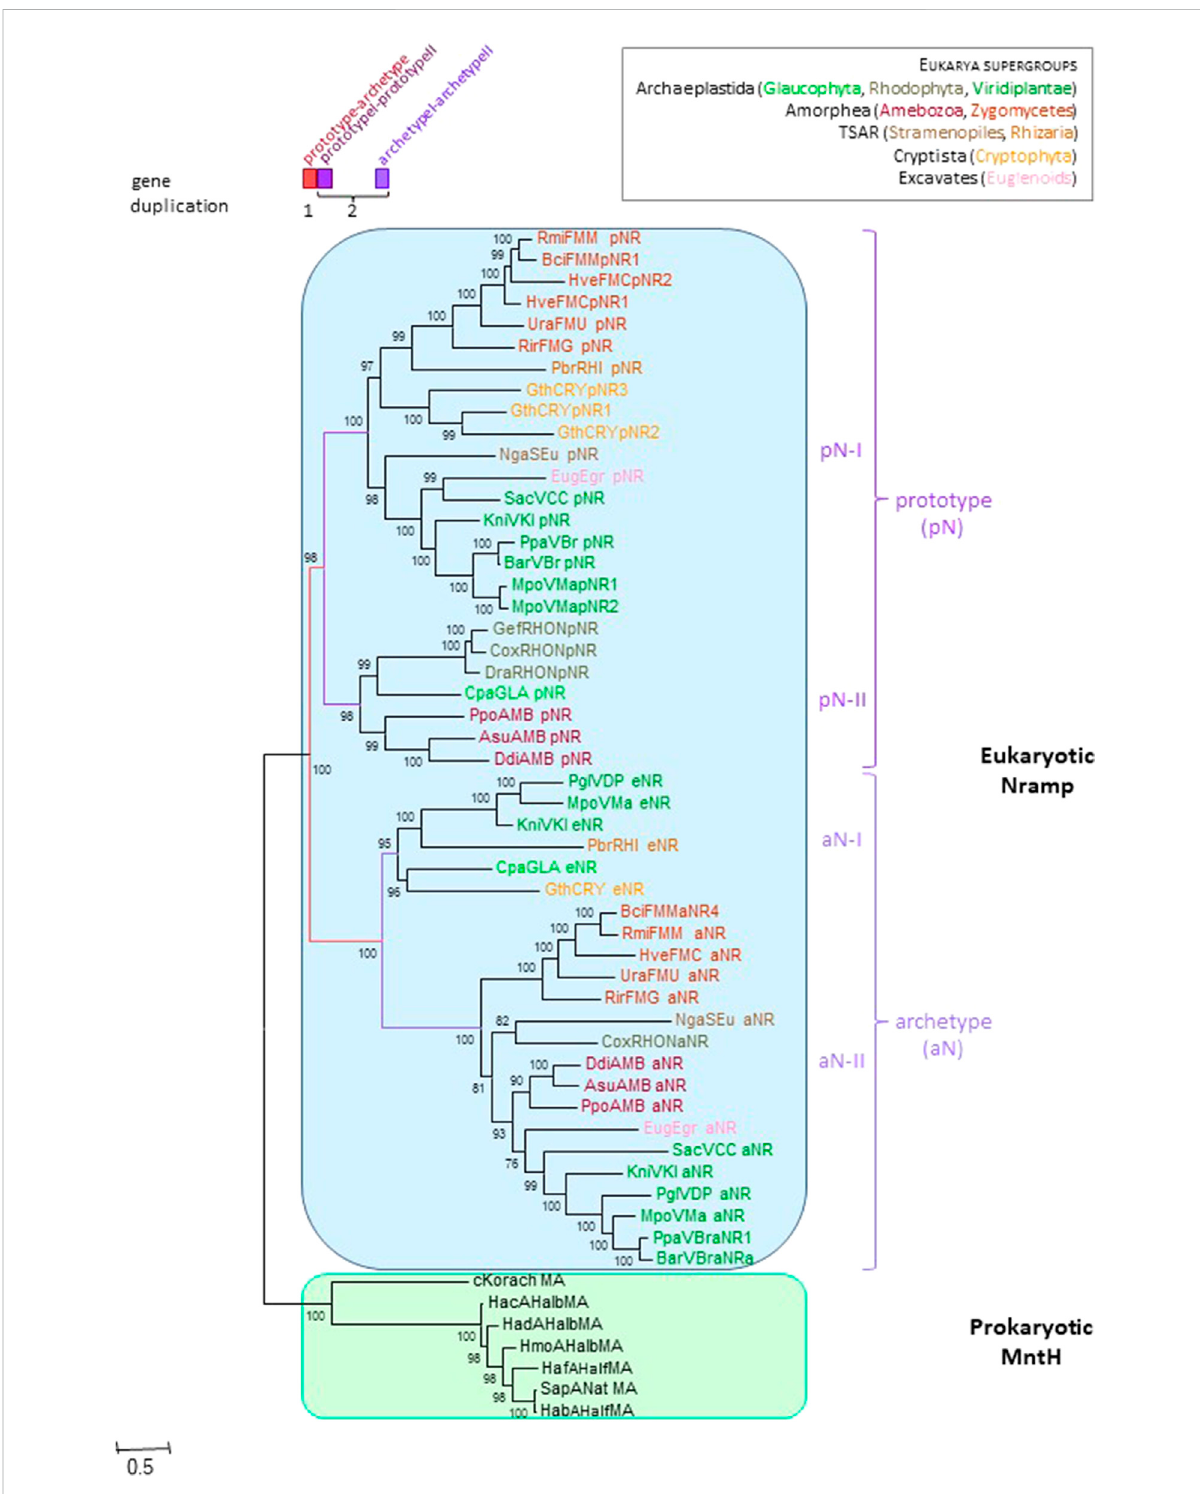
FIGURE 1 Nramp diversi fi cationearlyineukaryoteevolution.TheIQ-treepresentedused278parsimonyinformative(PI)sites,thesubstitutionmodelEX3, ML estimateofa.a. state frequency,freerate modelofvariation amongsiteswith 13categories(Leetal., 2008;Tri fi nopoulosetal., 2016).Sequences distribution( eukaryoticsupergroups ): Amorphea ,Fungi(FMM,MUC,FMC,FMG:pN-I&aN-II)andAmoeba(AMB:pN-II&aN-II); TSAR ,Stramenopiles (SEu: pN-I & aN-II) and Rhizaria (RHI: pN-I & aN-I); Archaeplastida , Green algae (VCC: pN-I & aN-II), Land plants (VKl, VMa: pN-I, aN-I & aN-II; VBr: pN-I & aN-II; VDP: aN-I & aN-II), Red algae (RHO: pN-II & aN-II) and Glaucophyta (GLA: pN-II & aN-I); Cryptophyta (CRY: pN-I & aN-I); Euglenozoa (Eug: pN-I & aN-II). Details are provided in the Supplementary Appendix (p. 11 –